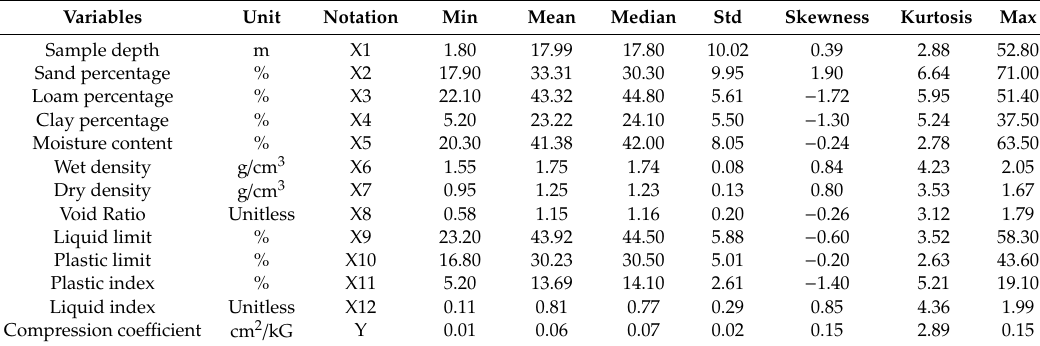
Table 1. The statistical description of the collected dataset.